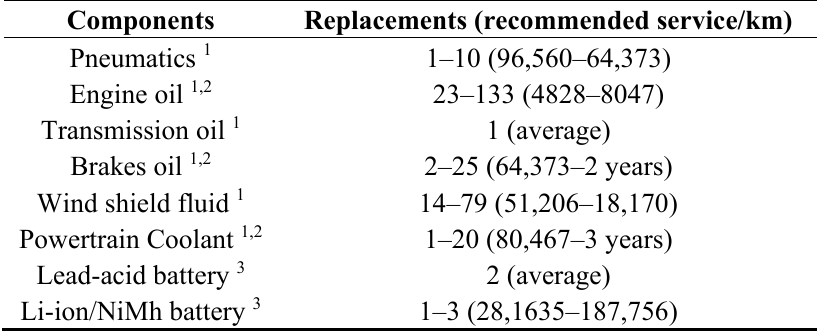
Table 5. Range of the number of replacements and corresponding servicing interval in kilometers in